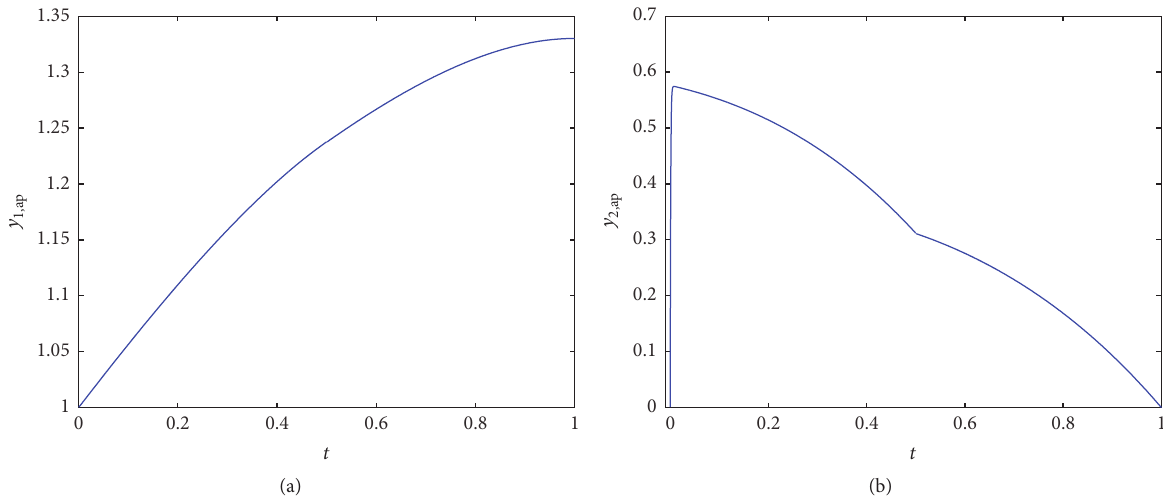
Figure 1: Graphs of the approximate solution 𝑦 1, ap and its first derivative 𝑦 2, ap for Example 1 at 𝜀 = 2 −9 and 𝑁 = 5 .